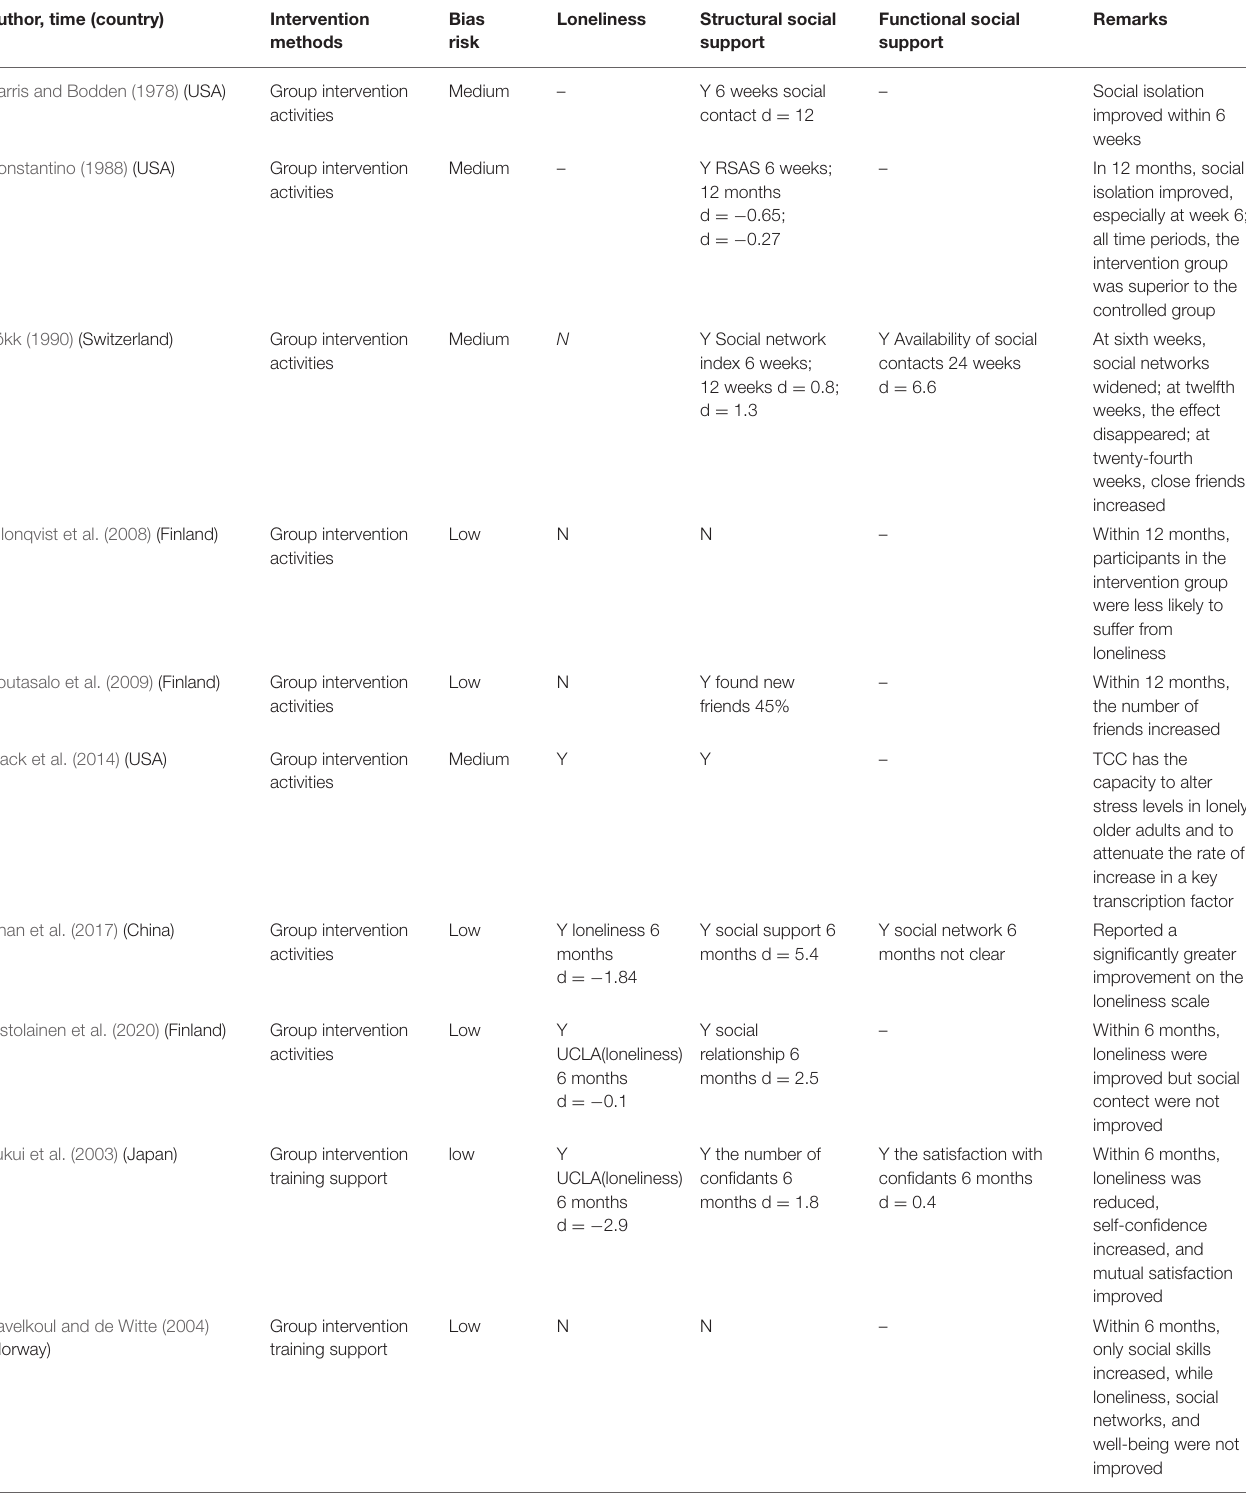
TABLE 3 | Study results for outcomes of loneliness, structural social support, and functional social